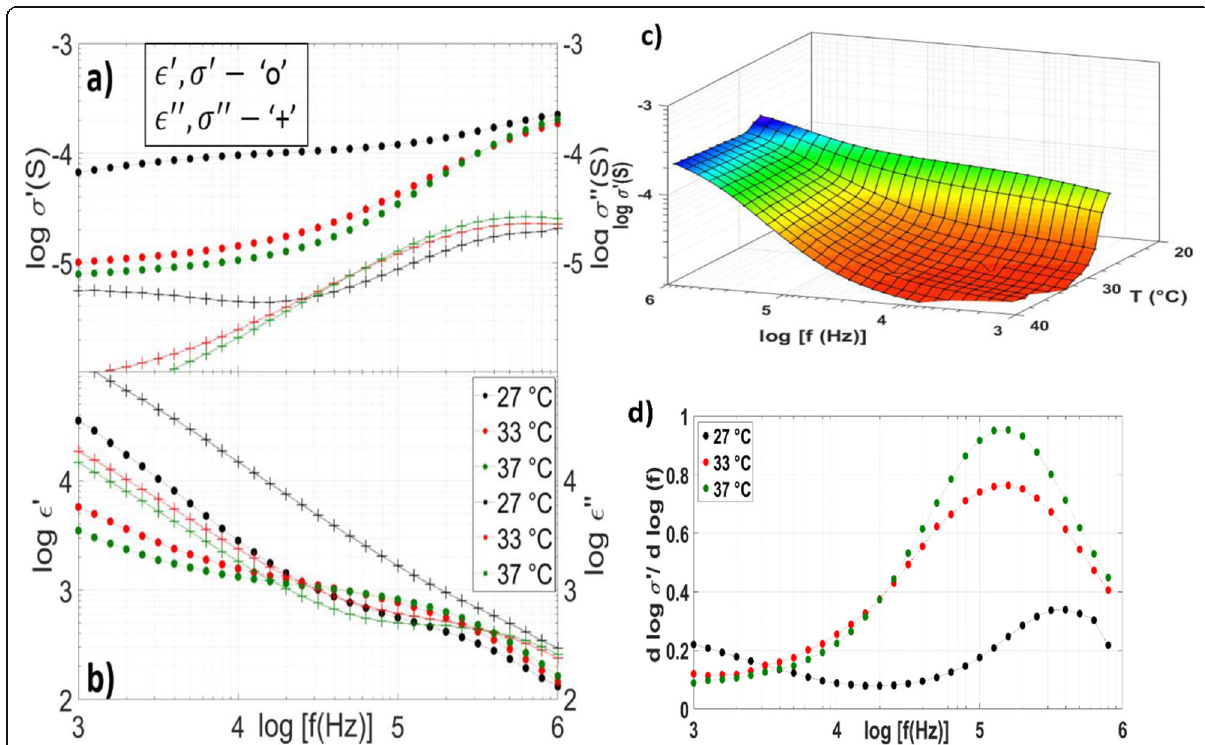
Fig. 1 Bulk PNIPAm temperature-dependent spectroscopy. Real and imaginary conductivity ( a , top left), dielectric constant ( b , bottom left) at 27 °C (black), 33 °C (red), and 37 °C (green) for bulk PNIPAm formed using free radical polymerization. c (top right) The temperature (T) – dependent conductivity σ ′ ( f , T ) shows a strong decrease around the phase transition temperature of ~ 32 °C. d (bottom right) d (log σ ′ )/d log (f) at 27 °C (black), 33 °C (red), and 37 °C (green) showing the extent of MWS polarization in the